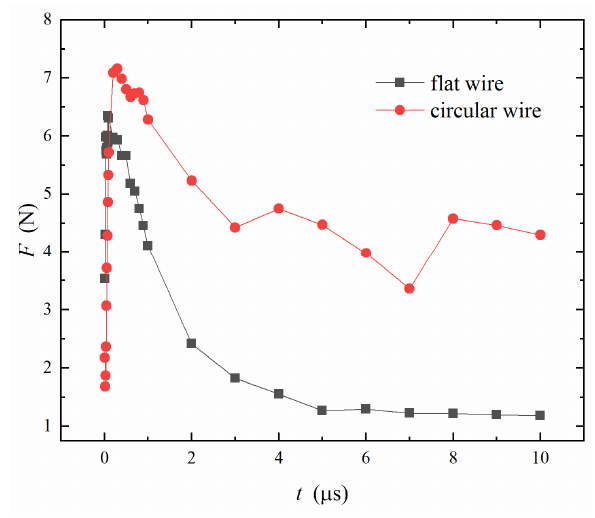
Figure 8. Wall force variation diagram.